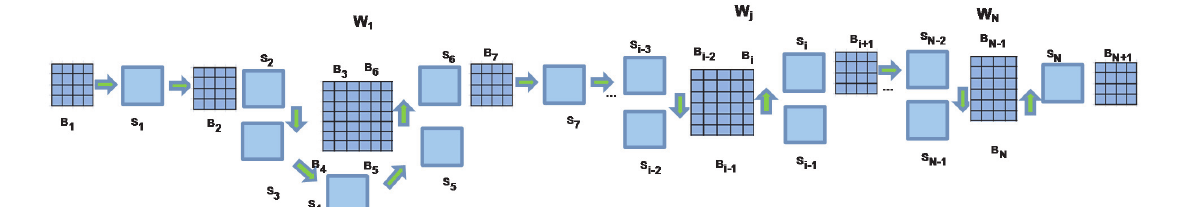
Fig. 3. Variable station work cells with serial stations in between using buffer cluster